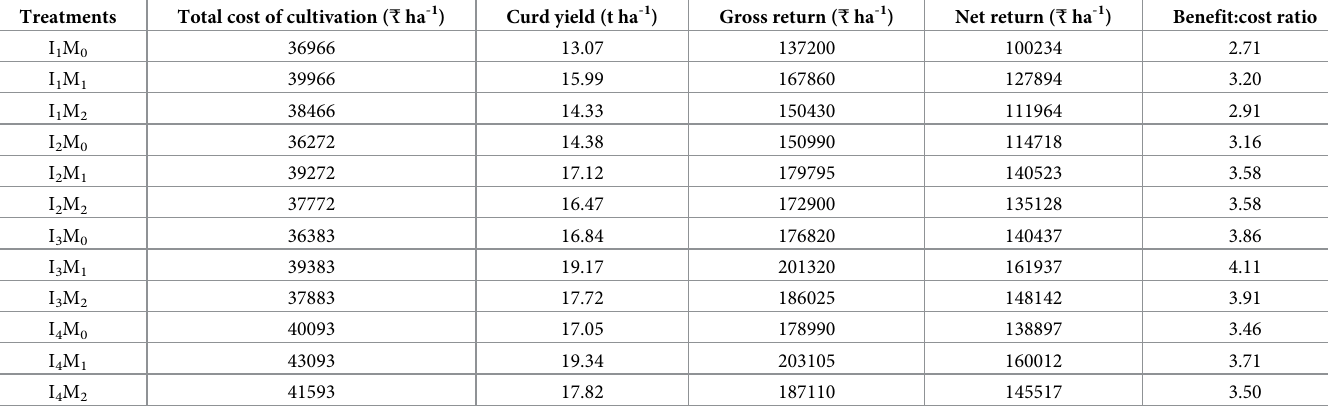
Table 6. Economics of broccoli cultivation as influenced by different levels and methods of irrigation and mulches (average data of 3-year). Treatments Total cost of cultivation ( ₹ ha -1